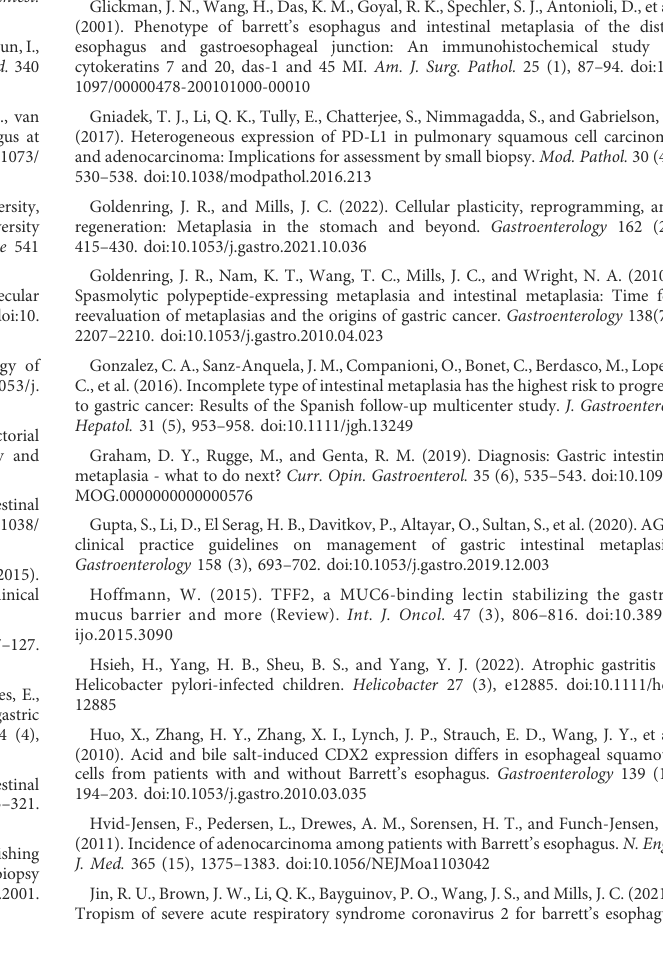
SUPPLEMENTARY TABLE S1 The Fisher ’ s exact test p -values of IHC marker expression for esophageal cases. P-values were calculated by testing for the difference in the mean IHC scores of the indicated markers. Fisher ’ s exact test was used. P < 0.05 is considered statistically signi fi cant. Comparisons were between normal and lesion phenotype groups, or 2 lesion phenotype groups (BE-NFD: Barrett ’ s esophagus negative for dysplasia, BE-LGD: Barrett ’ s esophagus with low-grade dysplasia, BE-HDG: